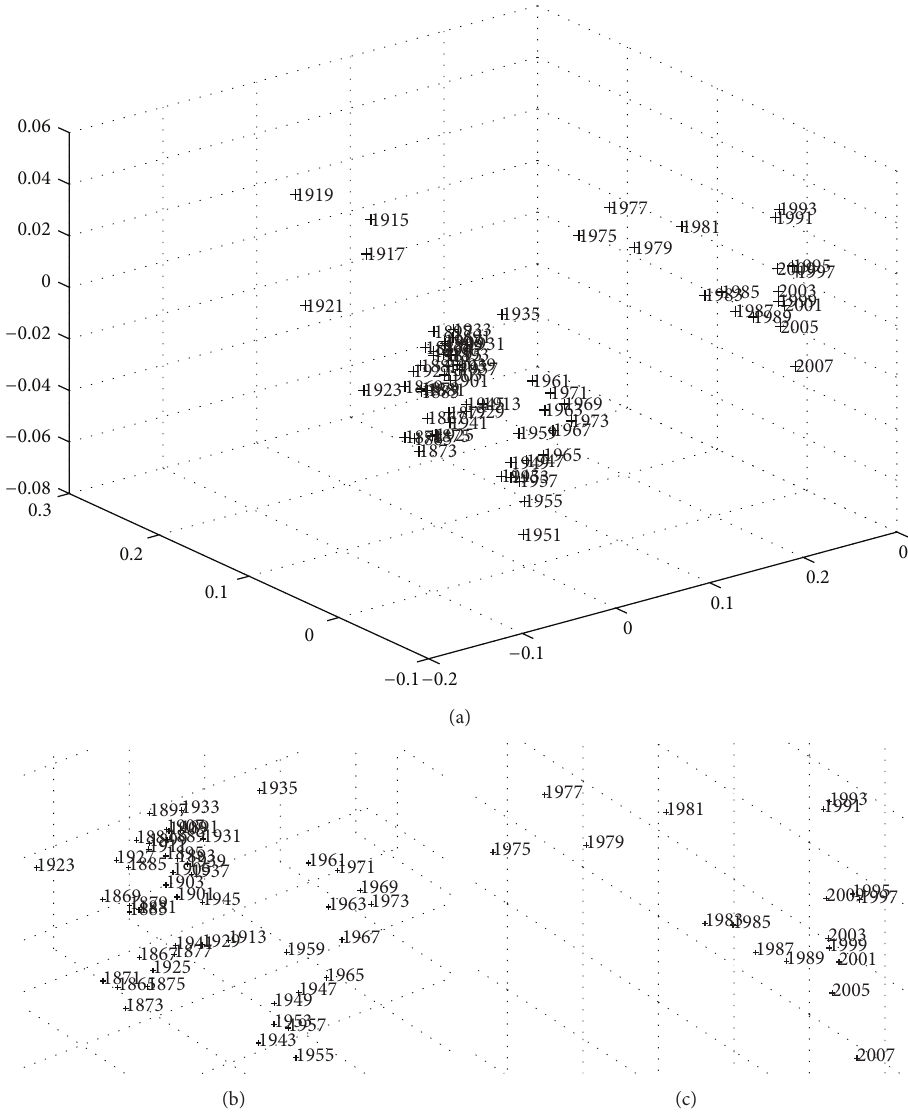
Figure 4: Three-dimensional MDS map of the Portuguese economic evolution, in the perspective of the Cosine correlation 𝑟 𝐶 , 𝑇 = 1865 – 2010 , and ℎ = 2 years. The two charts magnify the two clusters in the middle and right